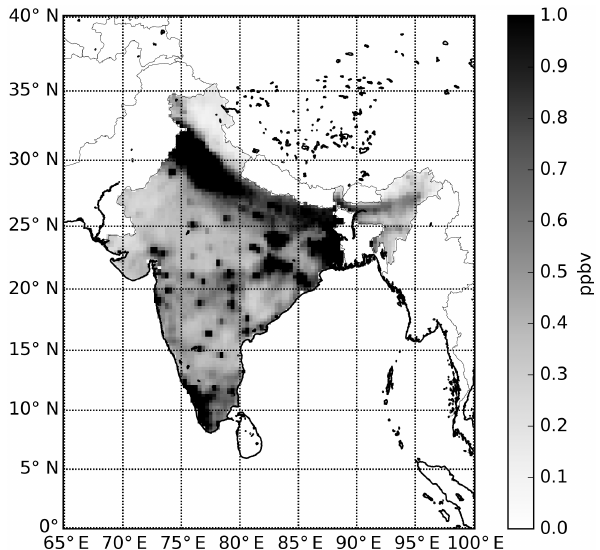
Figure 9. Annual mean GEOS-Chem ground-level NO x mixing ra- tios (ppbv) in 2014, averaged on the 0 . 25 ◦ × 0 . 3125 ◦ grid.